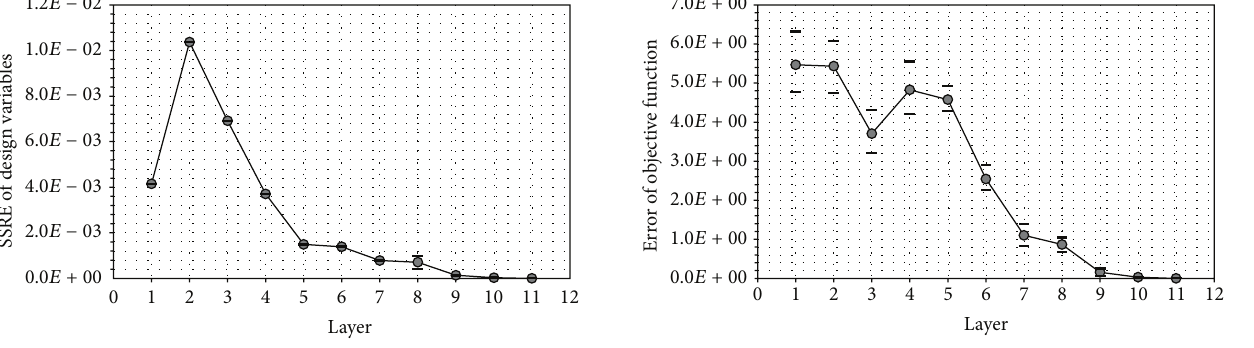
Figure 13: History of the accuracy of the approximated decision variables.